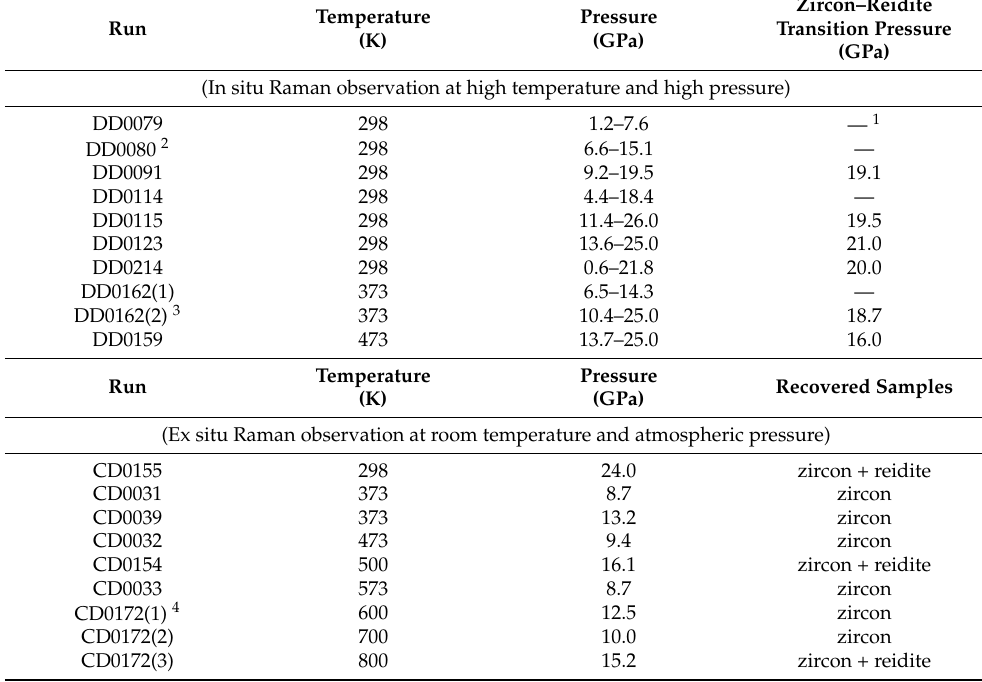
Table 1. Experimental conditions and results.